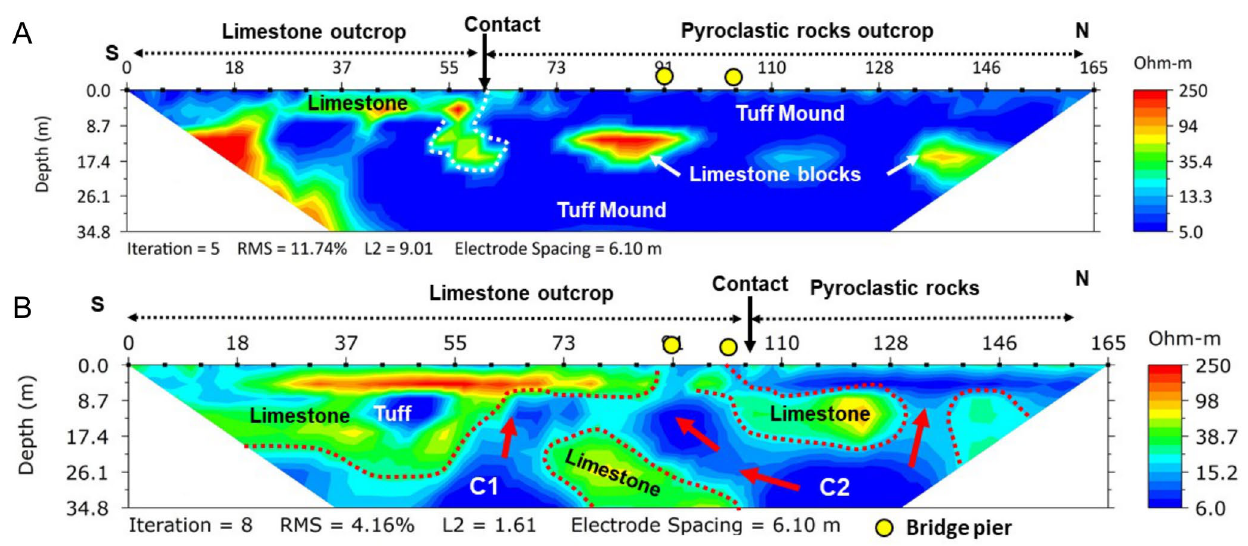
Figure 7: Resistivity profiles of P1 and P2 obtained from the western [A] and eastern [B] side of St. Elmo railroad track, respectively (see Figure 6 for locations). Boundaries of exposed pyroclastic and limestone outcrops, the contact, and most southern and northernmost bridge piers are shown for reference